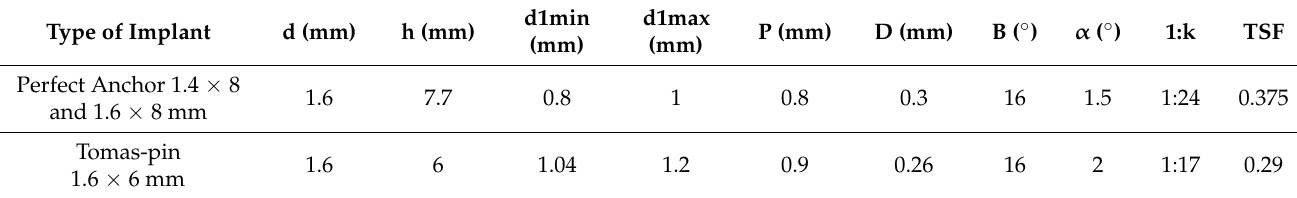
Table 1. Values of geometric parameters of mini-implants established by measurement.